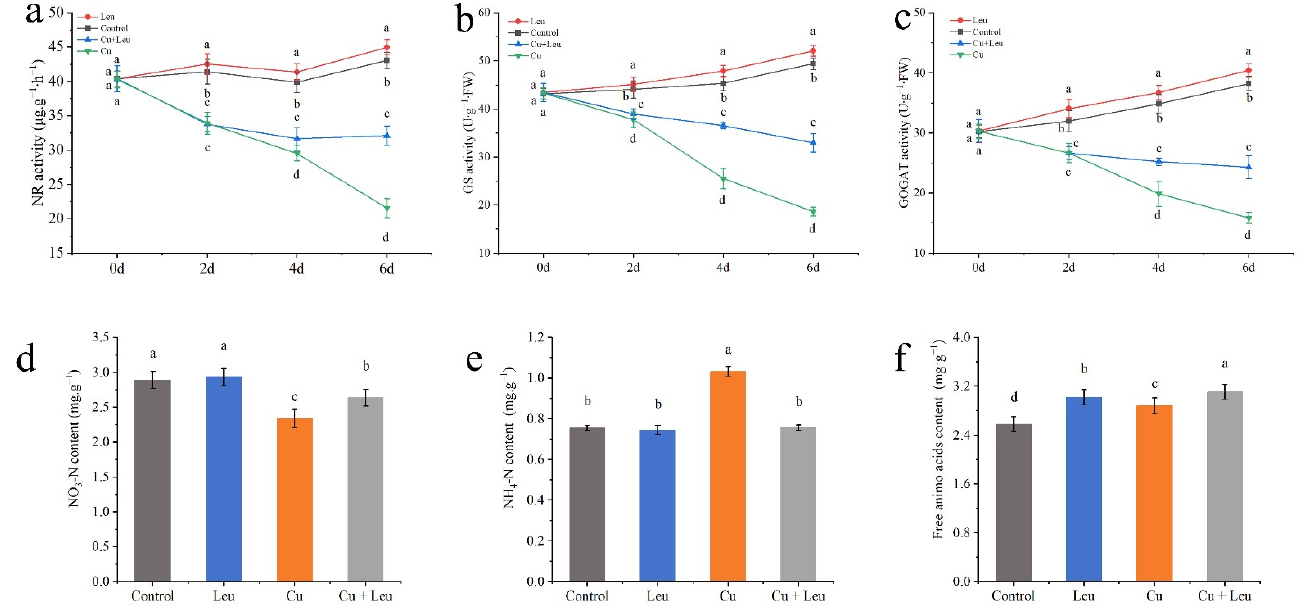
Figure 6 . Effects of different treatments on nitrogen metabolism in peach seedlings. ( a ) Nitrate reductase (NR) activity; ( b ) glutamine synthase (GS) activity; ( c ) glutamic acid synthetase (GOGAT) activity; ( d ) nitrate–nitrogen (NO 3 -N) content; ( e ) ammonium–nitrogen (NH 4 +-N) content; ( f ) free amino acid content. Error bars represent standard deviations of the means ( n = 3). Different lowercase letters indicate significant differences among different treatments (Duncan test, p < 0.05).